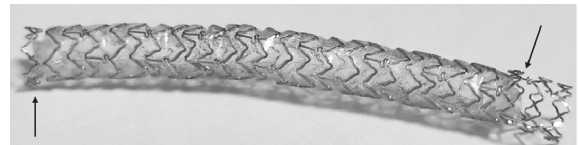
Figure 1: Self-made polyurethane-covered stent. The figure depicts the self-made polyurethane-covered stent covered by 3M ™ Tegaderm ™ transparent film dressing